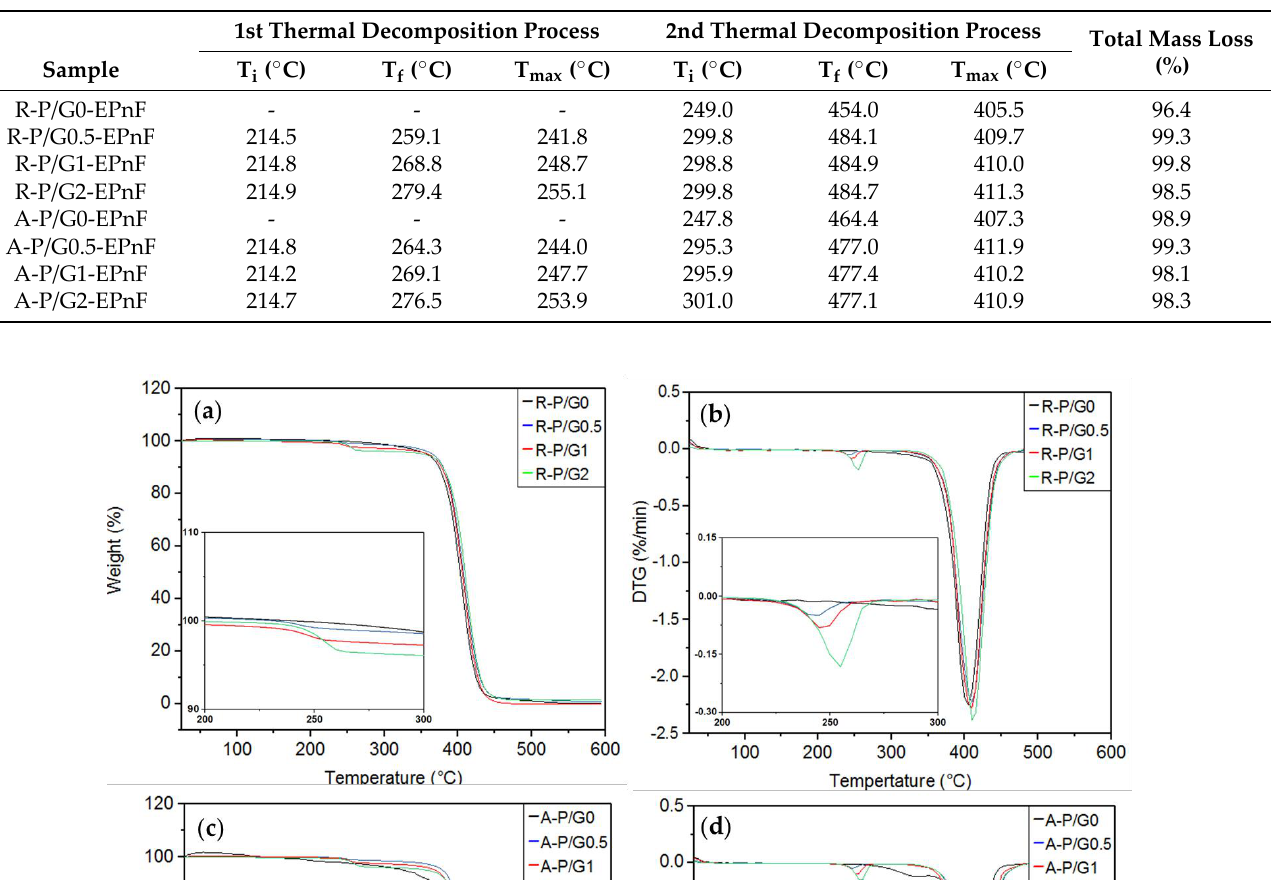
Table 5. TGA of R‑P/G‑EPnF and A‑P/G‑EPnF meshes.